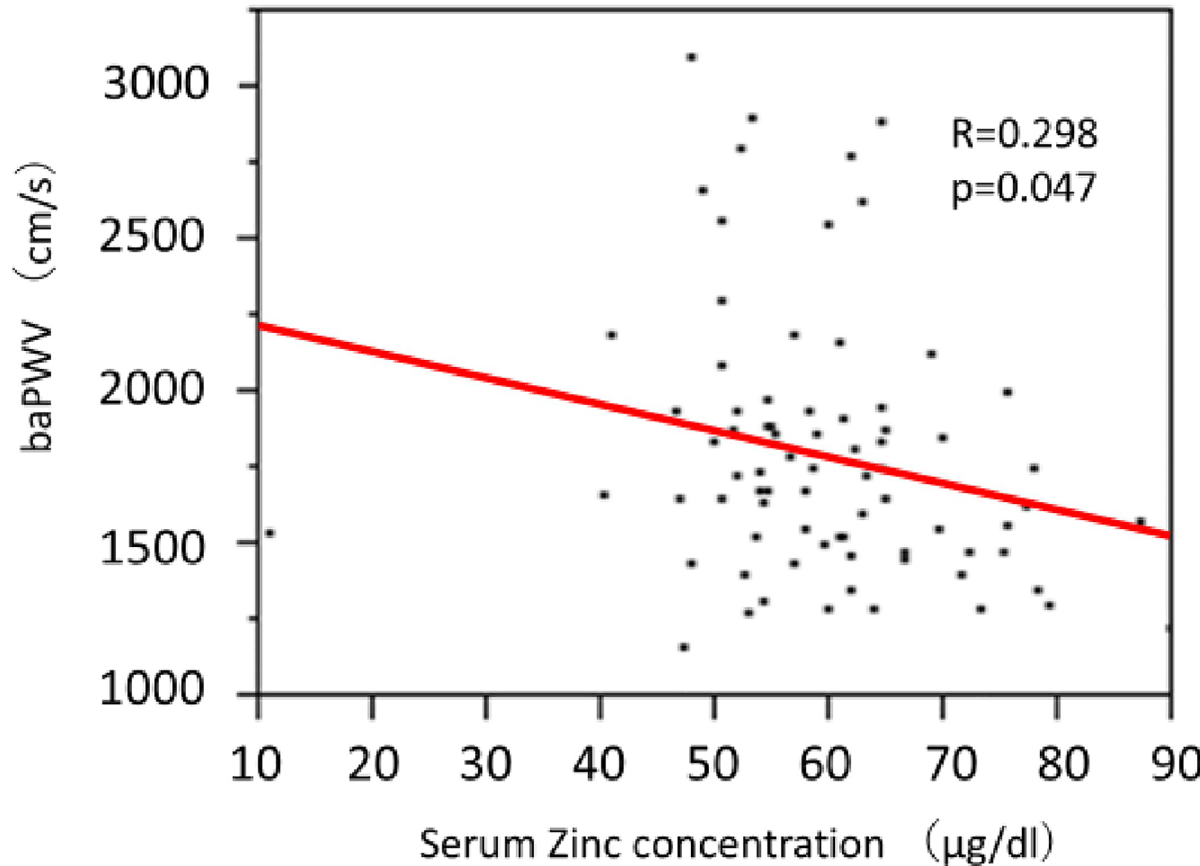
Fig 3. Relationship between serum zinc concentration and baPWV. Serum zinc concentration and baPWV significantly and negatively correlated (r = 0.298, p = 0.047). baPWV, brachial-ankle pulse wave